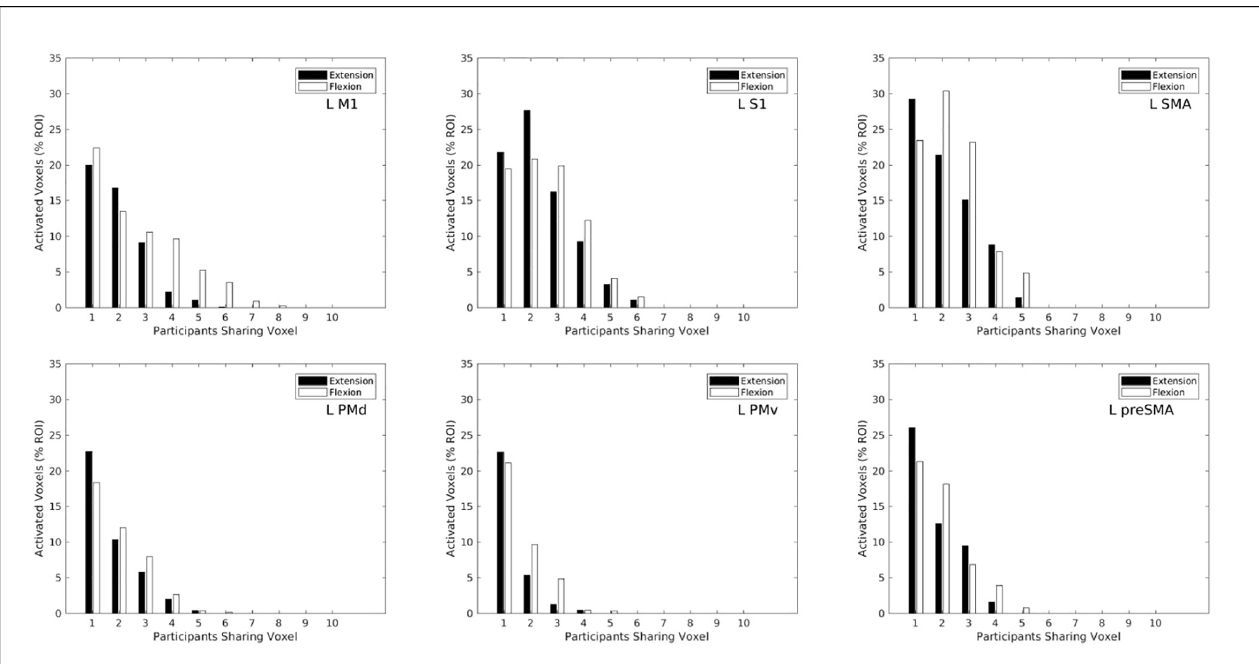
Fig 6. Histograms comparing wrist extension (black bars) and wrist flexion (white bars) for how many activated voxels (p < 0.001, uncorrected) shared the indicated “winner-take-all” action preference as a function of the number of participants sharing that voxel. Ordinate height of each bar represents a count of activated voxels (scaled as percentage of all voxels in the selected ROI) that share the same action preference across a given number of participants. Voxels were counted across all participants, using the MNI coordinate system as a common space. The “winner take all” criterion for action preference evaluated which action produced the larger t-statistic in each activated voxel. Different panels present results for the six left hemisphere ROIs from the Human Motor Area Template (top row: left M1, left S1, left SMA; bottom row: left dorsal premotor, left ventral premotor, left pre-SMA).